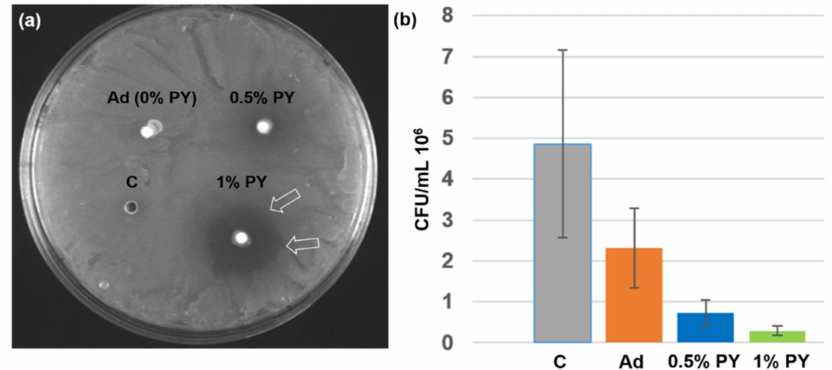
Figure 3. ( a ) Agar diffusion test with the adhesive (Ad), adhesive + 0.5% PY (0.5% PY), and adhesive + 1% PY (1% PY) (white arrows for the inhibition zones). ( b ) Number of CFU of S. mutans in the presence of the adhesive (Ad), adhesive + 0.5% PY (0.5% PY), and adhesive + 1% PY (1% PY) after 24 h of incubation at 37 ◦ C. C: bacterial